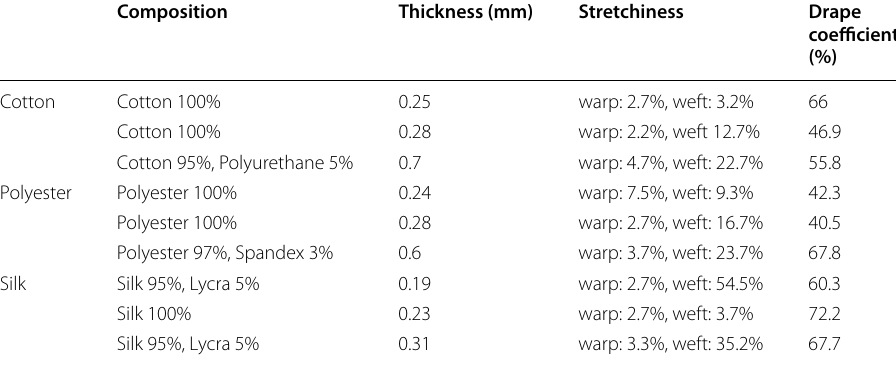
Table 2 Description of the sample fabrics Composition Thickness (mm) Stretchiness